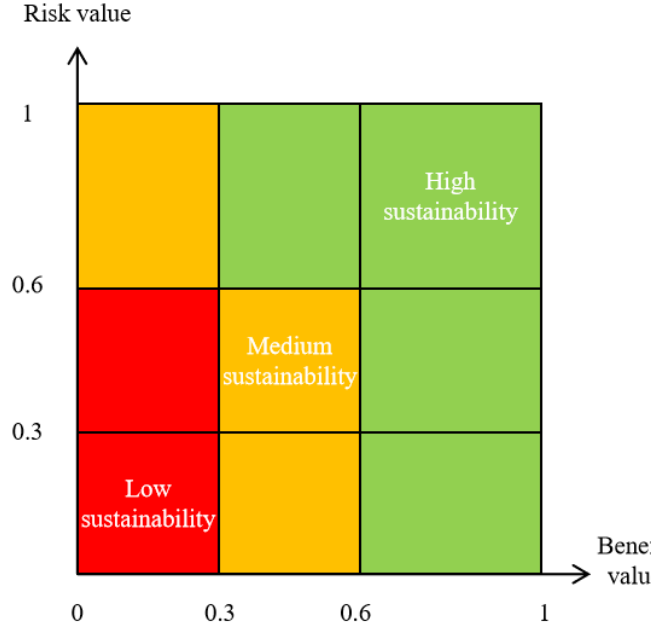
Figure 2. The classification interval for contaminated site risk management.